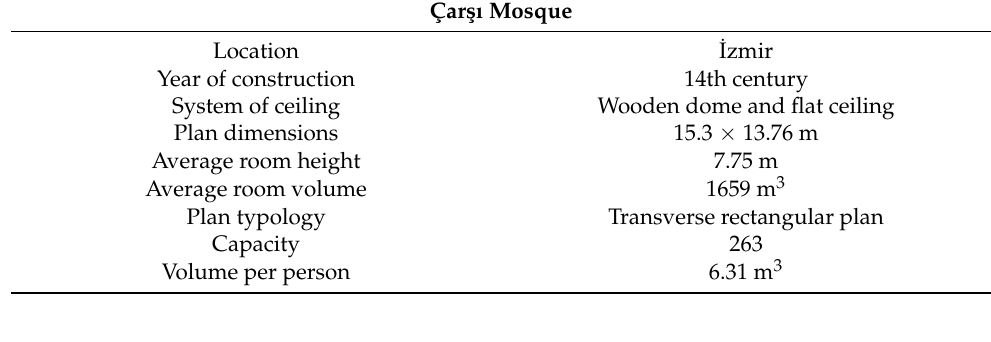
Table 7. The architectural features of Çar¸sı Mosque.